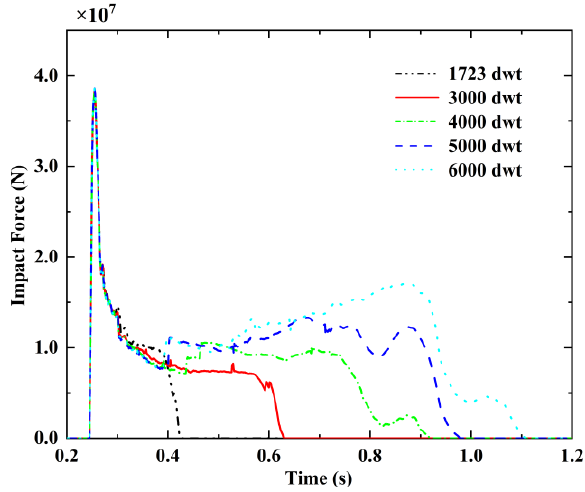
Figure 19. Comparison of impact forces under different barge mass.